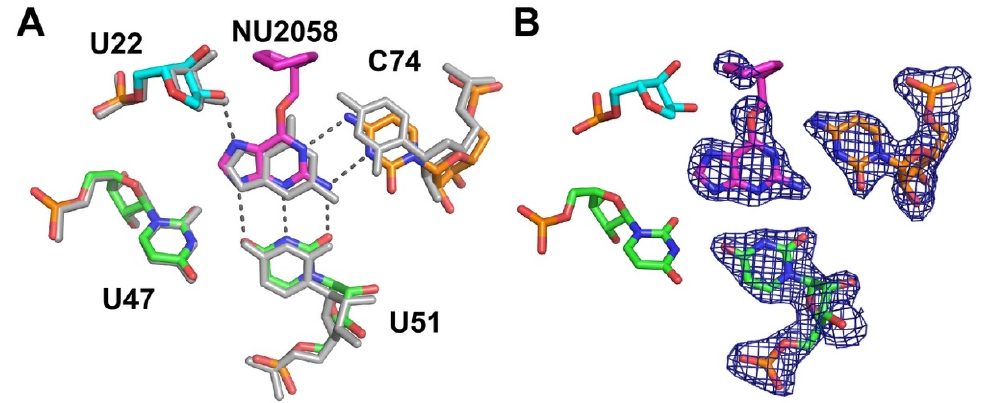
Figure 3. Recognition of NU2058 by GR. ( A ) Hydrogen bonding interactions between NU2058 and GR. The binding pocket of the guanine-GR complex is superimposed, emphasizing the shift of C74 towards the minor groove, resulting in two hydrogen bonds between the ligand and RNA. ( B ) Binding pocket of the NU2058-GR complex with density from a simulated annealing composite map contoured at 1 around the ligand and nucleotides U51 and C74. Only two atoms in the methylcyclohexyl group have a clear density, indicating that this moiety of the ligand is highly conformationally